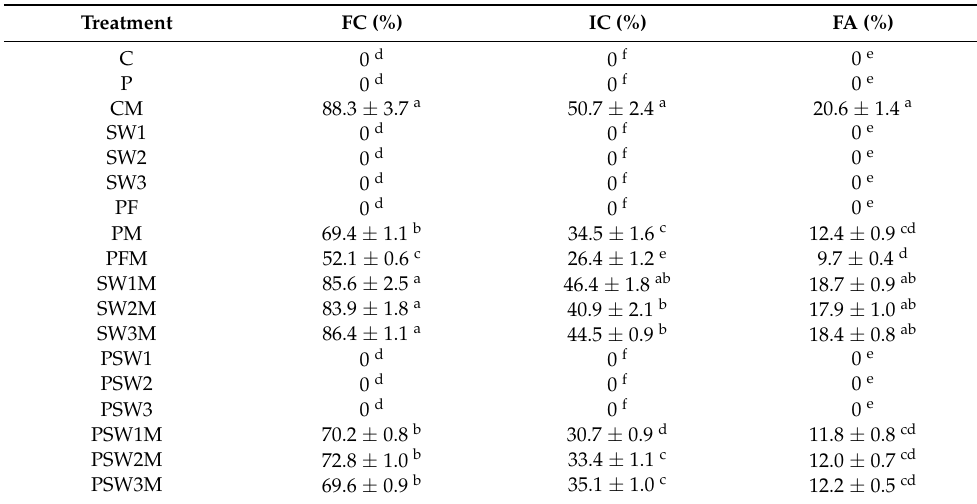
Table 7. Mycorrhizal colonization in roots of pea (cv. Master-B) infected with Rhizoctonia root rot and/or treated with the seaweed extract at 30 days post-inoculation